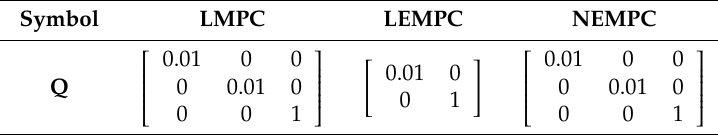
Table 9. Changed parameters in controllers.